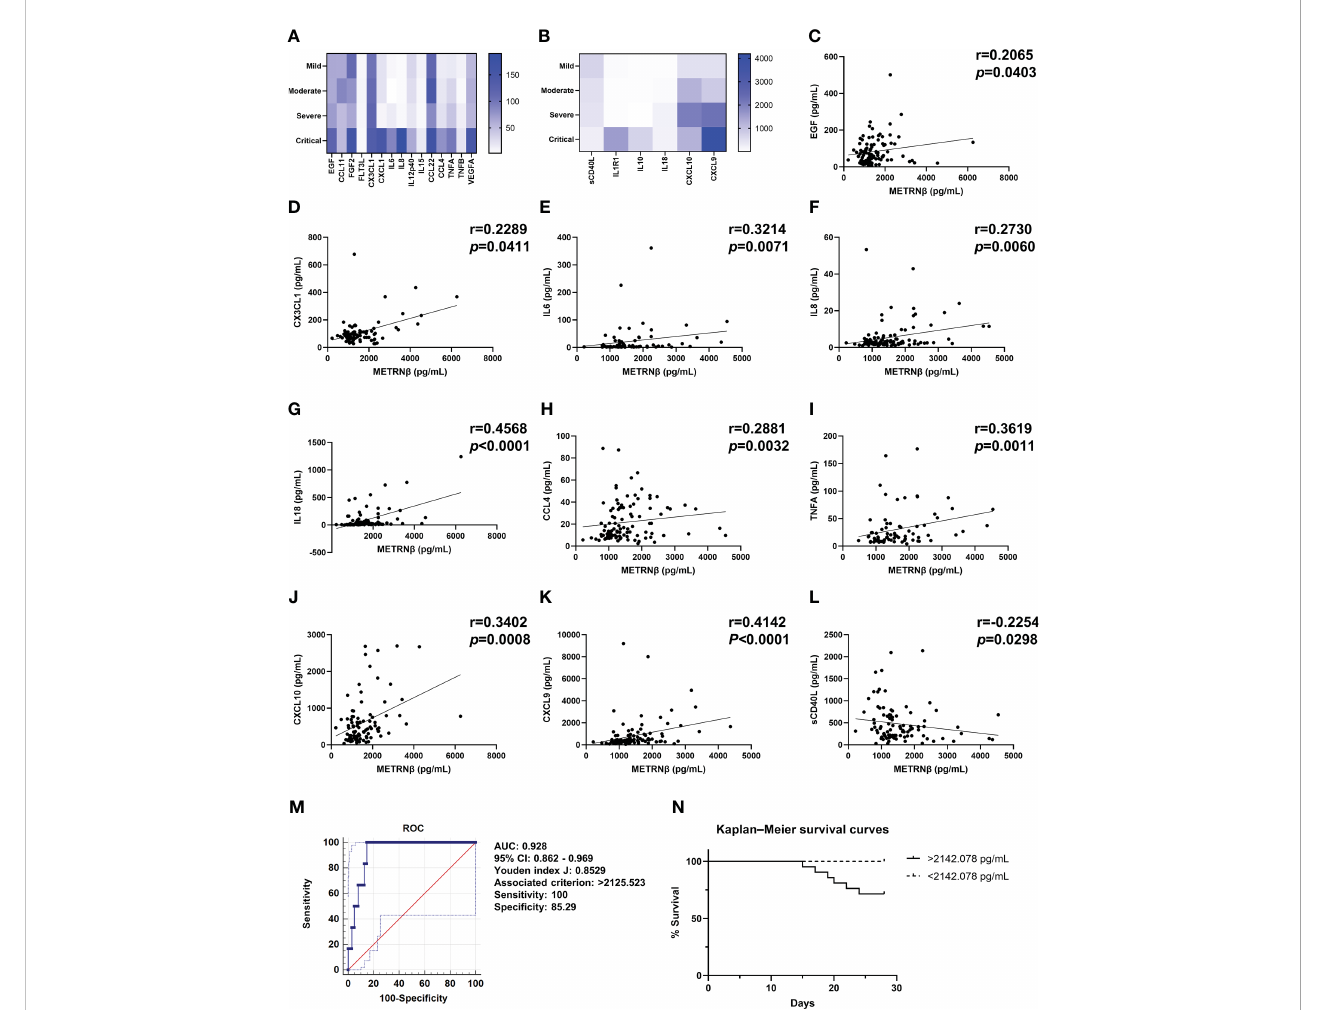
FIGURE 6 Validation of METRN b as a biomarker in patients infected with Omicron-SARS-CoV-2. (A, B) Longitudinal cytokine/chemokine pro fi le of COVID-19 patients with Omicron-SARS-CoV-2 infections (n = 69 – 108) analyzed using the human Cytokine Milliplex MAP assay kit. The results were shown as heat maps. (C – L) Correlation analysis of serum METRN b concentration with EGF (n = 99), CX3CL1 (n = 80), IL6 (n = 69), IL8 (n = 100), IL18 (n = 102), CCL4 (n = 103), TNFA (n = 78), CXCL10 (n = 93), CXCL9 (n = 101), and sCD40L (n = 93). Spearman ’ s correlation coef fi cient was used for correlation analysis. (M) ROC of serum METRN b at admission to distinguish non-survivors from survivors among the Omicron-COVID-19 patients. The AUC was 0.928 (95% CI: 0.862 – 0.969) for serum METRN b levels at admission in the validation cohort of COVID-19 patients with Omicron-SARS-CoV2 infections (n = 108). (N) Kaplan – Meier survival curves of COVID-19 patients in the Omicron validation cohort based on the METRN b cutoff value (2142.078 pg/mL) calculated from non-omicron prediction cohort. AUC, area under the